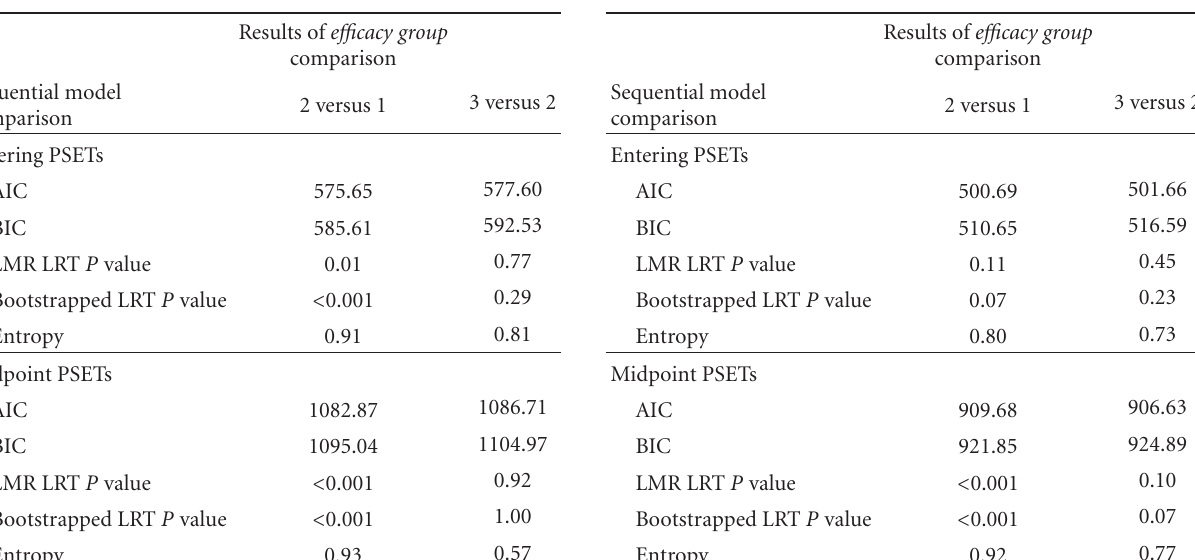
Table 1: Fit indices for PMTE. Table 2: Fit indices for